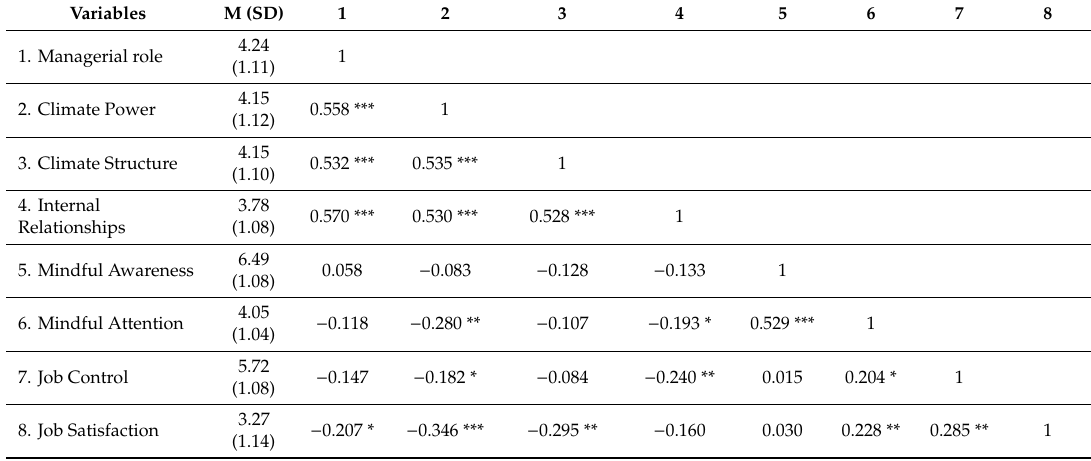
Table 2. Study variables: descriptive statistics and bivariate correlations ( n =